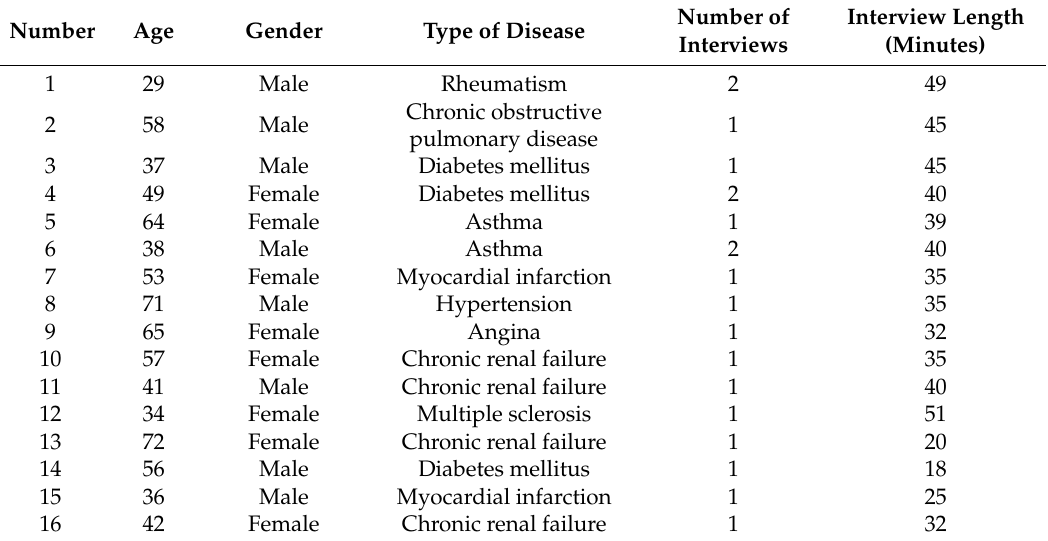
Table 1. Participants’ characteristics.